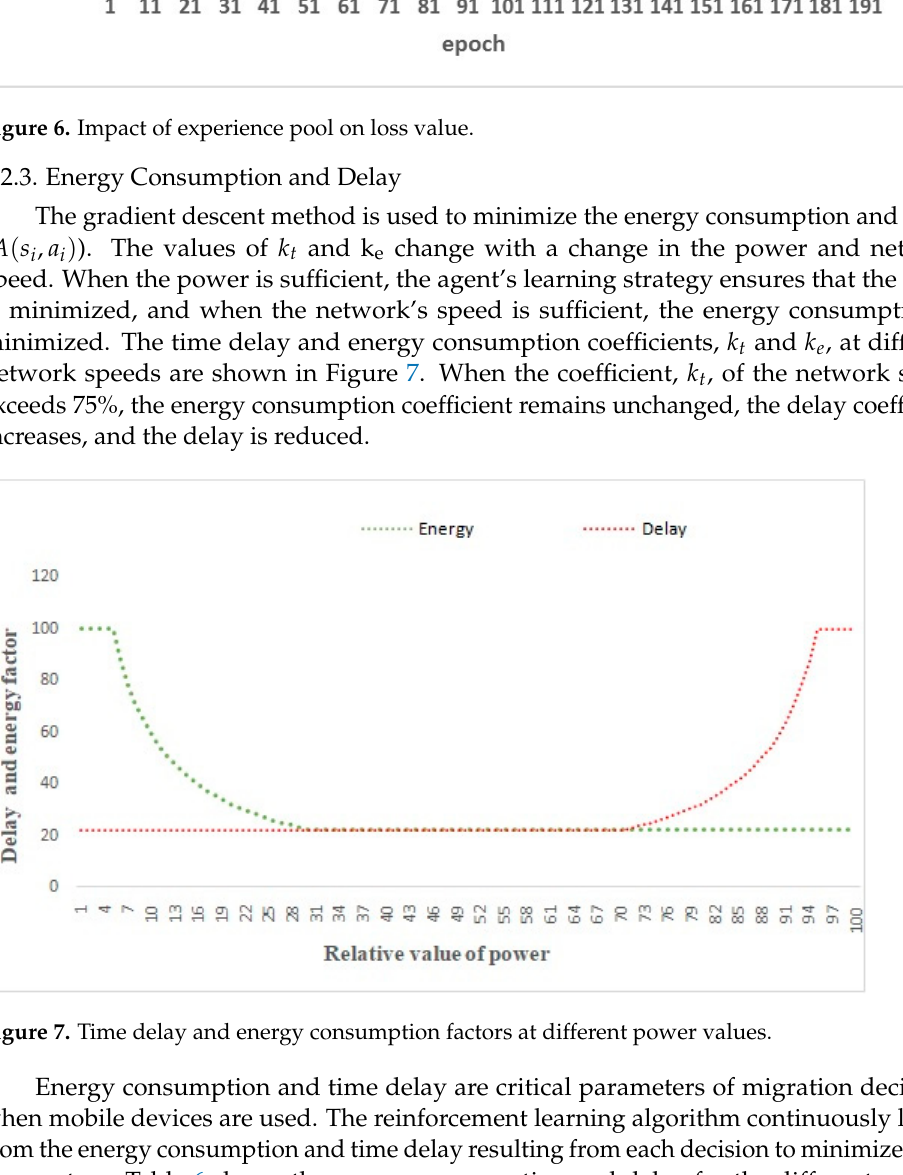
Table 6. Comparison of energy consumption and delay for different